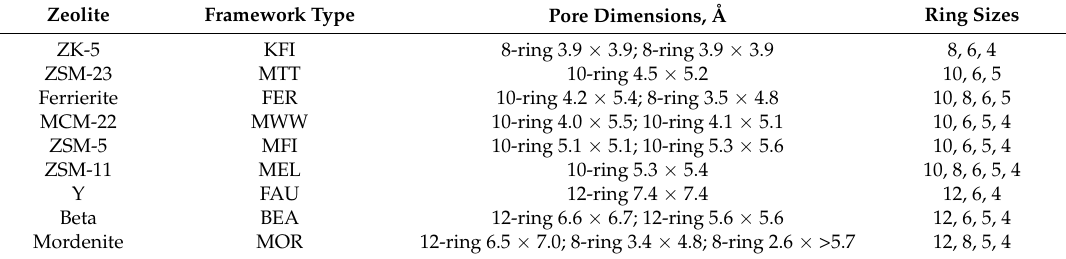
Table 1. Pore structures of different zeolites used in catalytic fast pyrolysis process.